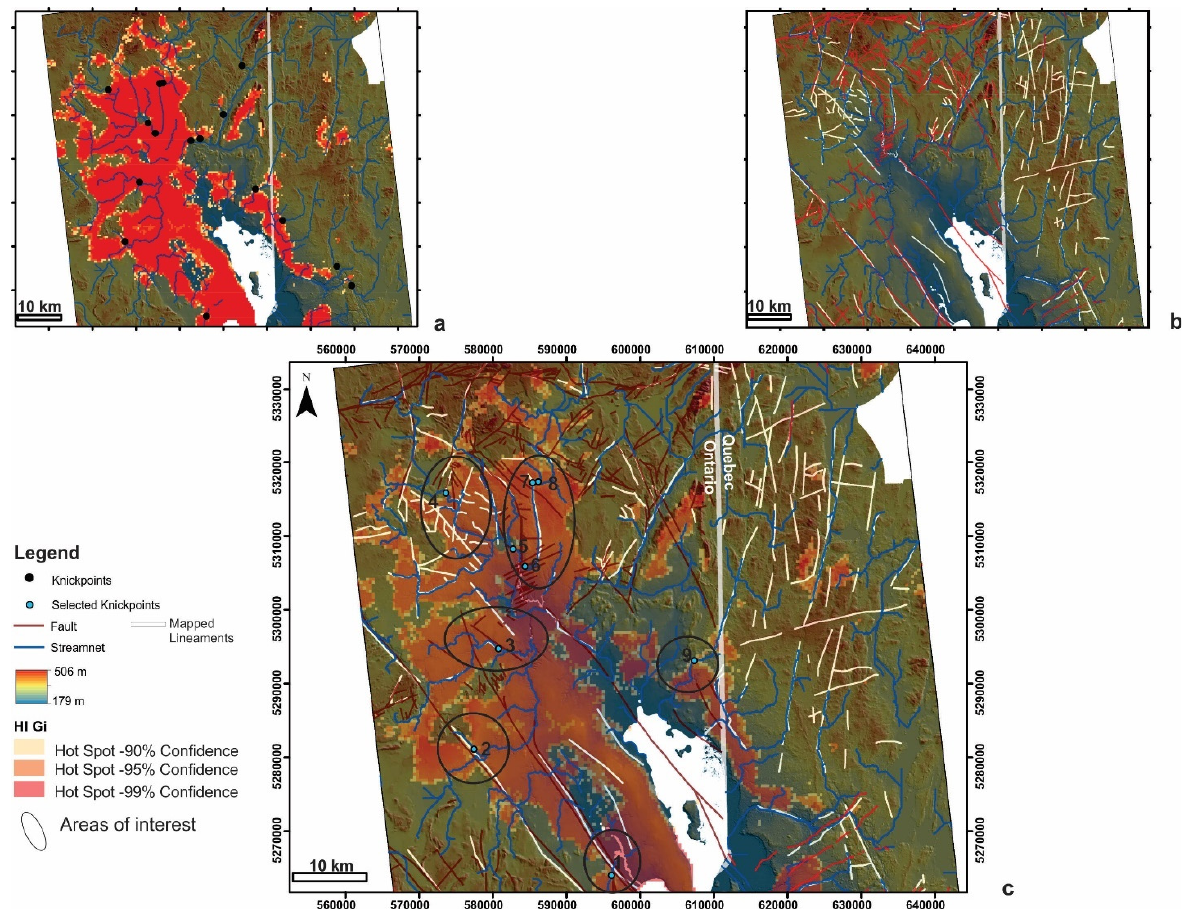
Figure 9. Synthesis for Subset Area 5. ( a ) Location of all knickpoints obtained at the resolution of 30 m and areas of HI Hot Spot (see Figure 6b for complete autospatial correlation of HI values). The knickpoints that are completely within the red area outlined by the HI Hot Spot are “selected” knickpoints; ( b ) lineaments hand mapped in this study compared with known structural features [119–121]; ( c ) synthesis of the two datasets with Areas of Interest (AoI) indicated with black ovals. The AoI for this subset are coincident with known structural features, providing validation of the techniques and of the workflow that is illustrated in this contribution.